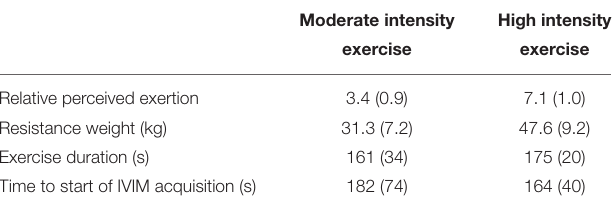
TABLE 1 | Results of exercise protocols for moderate and high intensity exercise